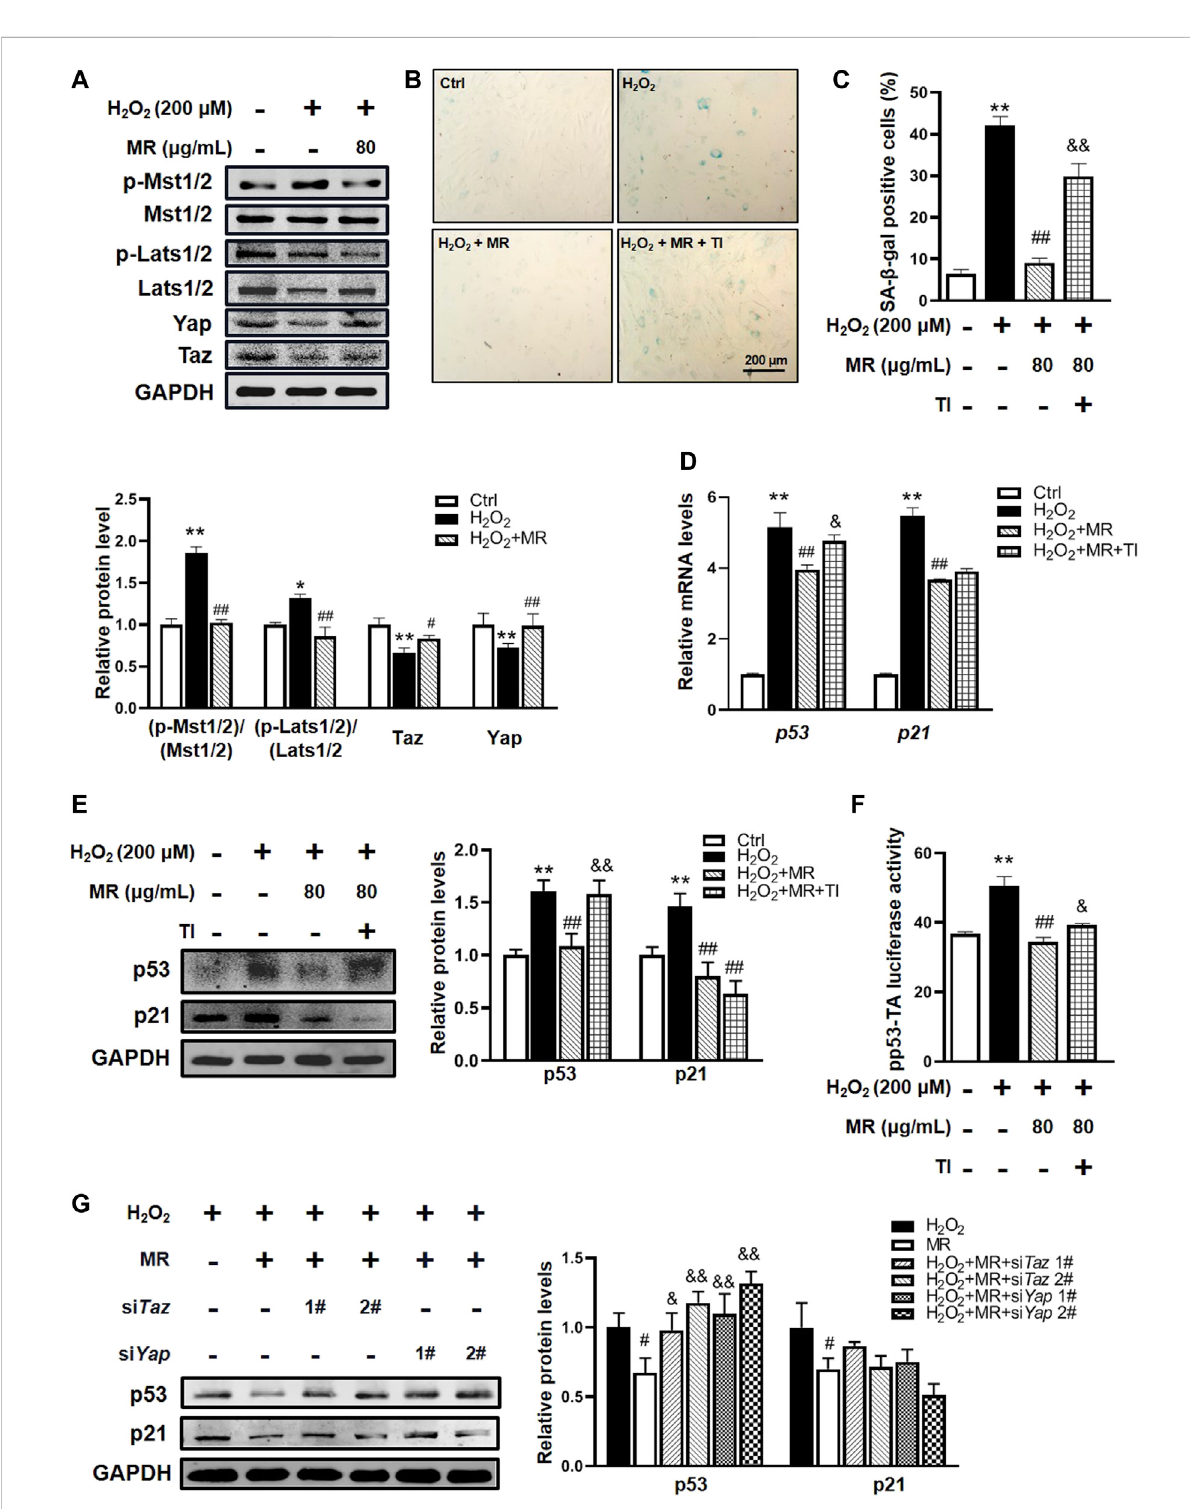
FIGURE 4 Hippo signaling participates in MR-mediated protection against H 2 O 2 -induced NP cell senescence. rNP cells were pretreated with the indicated concentrationofMR(200 μ M)for2 h,followedby200 μ MH 2 O 2 foranother2 h. (A) Westernblotanalysisresults. (B,C) SA- β -galstaininganalysis.rNPcells werepretreatedwith1 μ MYap/Tazinhibitor-1(YTI)and200 μ MMRfor2 handthentreatedwith200 μ MH 2 O 2 for2 h. (D) qPCRassaywasappliedtodetect the expression of p53 and p21 mRNA levels in rNP cells. (E) Western blot results of p53 protein expression in response to 1 μ M YTI treatment. (F) p53 luciferase reporter gene activity results. rNP cells were transiently transfected with a pp53-TA-luc-CP reporter plasmid and cultured with or without H 2 O 2 (200 μ M) or MR (200 μ M) or 1 μ M YTI for 48 h. Total cell lysates were subjected to luciferase assay. (G) Western blot results of p53 and p21 protein expressionsinresponseto200 μ MMRwithsiRNA-mediatedknockdownofTazorYap.rNPcellsweretreatedwithorwithoutH 2 O 2 andMR(200 μ M)after 24hofsiRNAtransfection.Dataarerepresentativeof3independentrepeatexperiments.Valuesareexpressedasmean±SD.*p < 0.05,**p < 0.01compared with control group. #p < 0.05, ##p < 0.01 compared with H 2 O 2 -treated cells. &p < 0.05, &&p < 0.01 compared with MR- and H 2 O 2 -treated